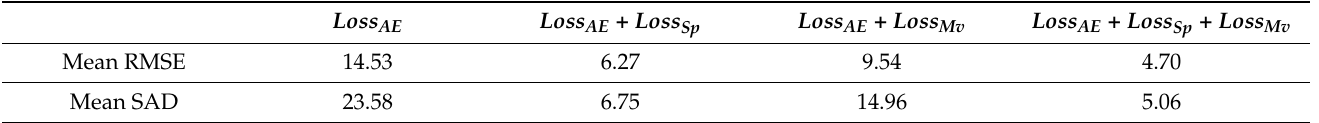
Table 10. Mean RMSE ( × 100) and mean SAD ( × 100) results of ablation experiments with various losses. Annotation: bold black text indicates the best